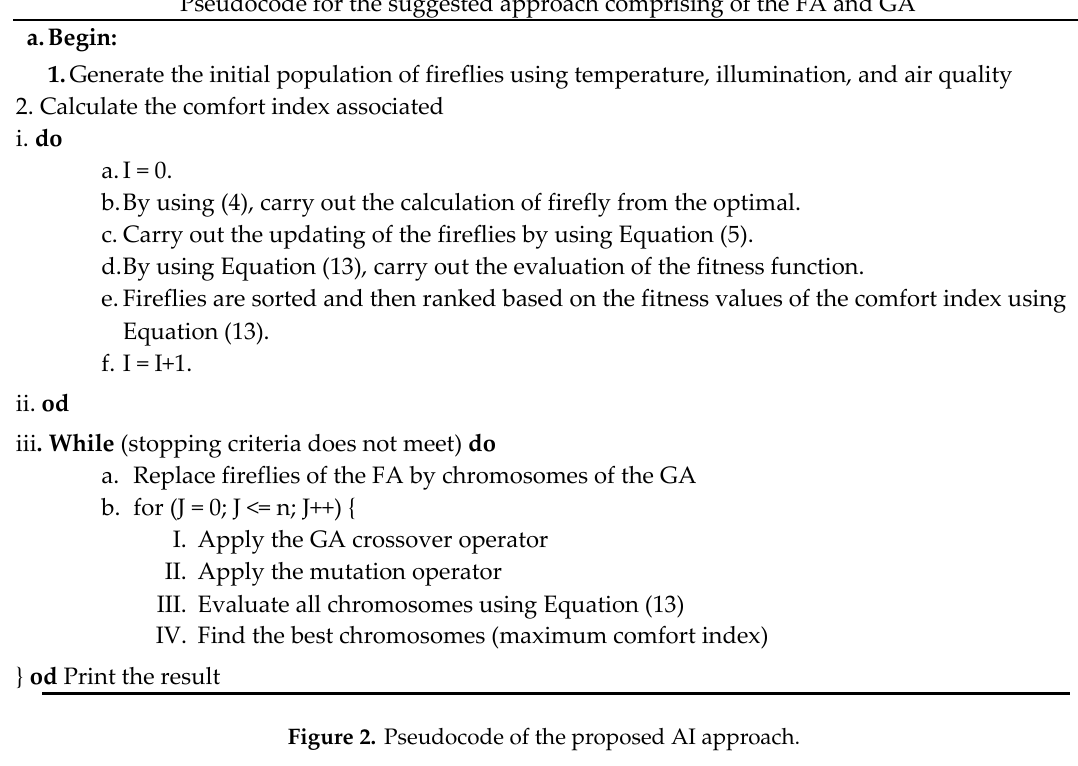
Figure 2. Pseudocode of the proposed AI approach